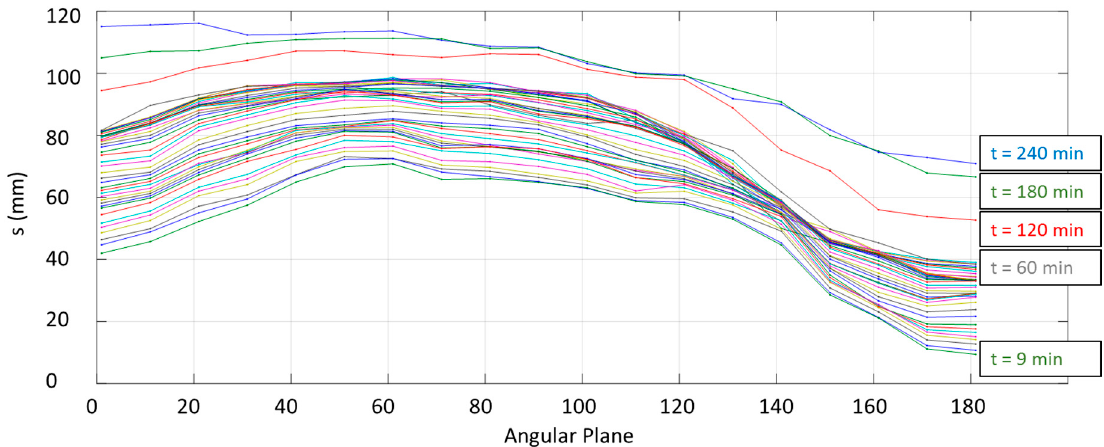
Figure 11. Average slope of radial profiles, at r = 5 mm, at the front and the sides of (or around) the cylinder during the development phase.